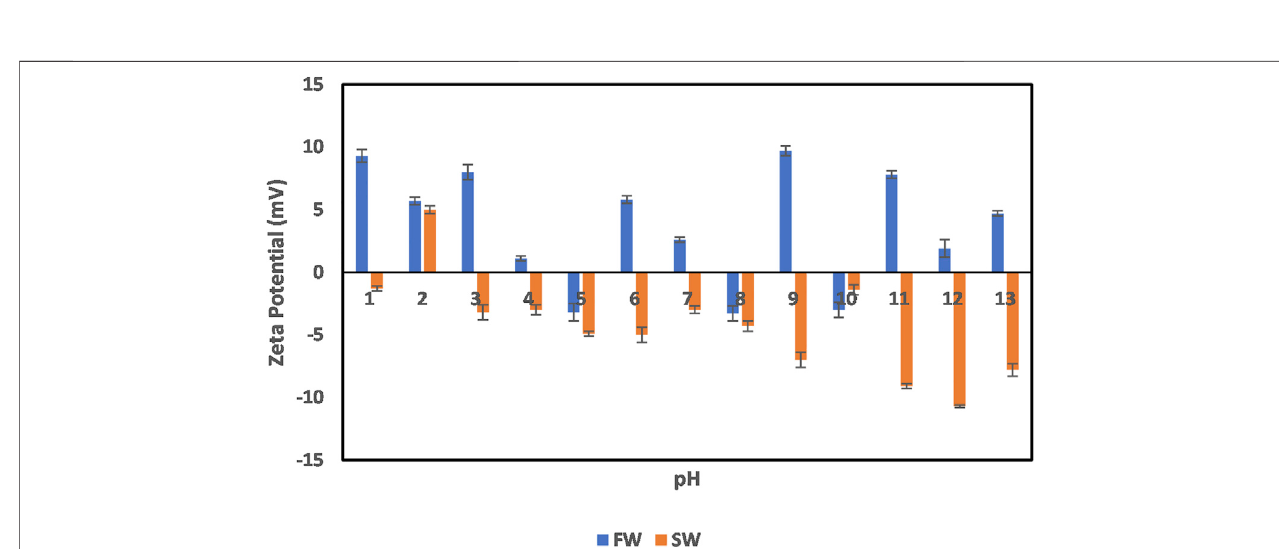
FIGURE 4 | Feldspar particle surface charge in DI, FW, and SW.